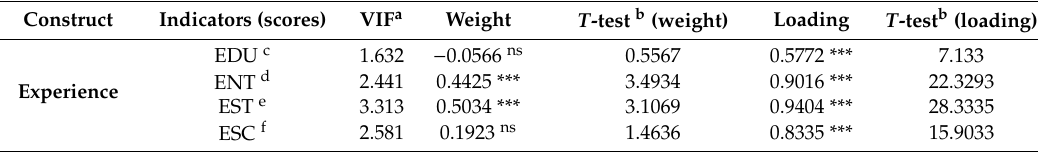
Table 8. Collinearity statistics and analysis of formative indicators.